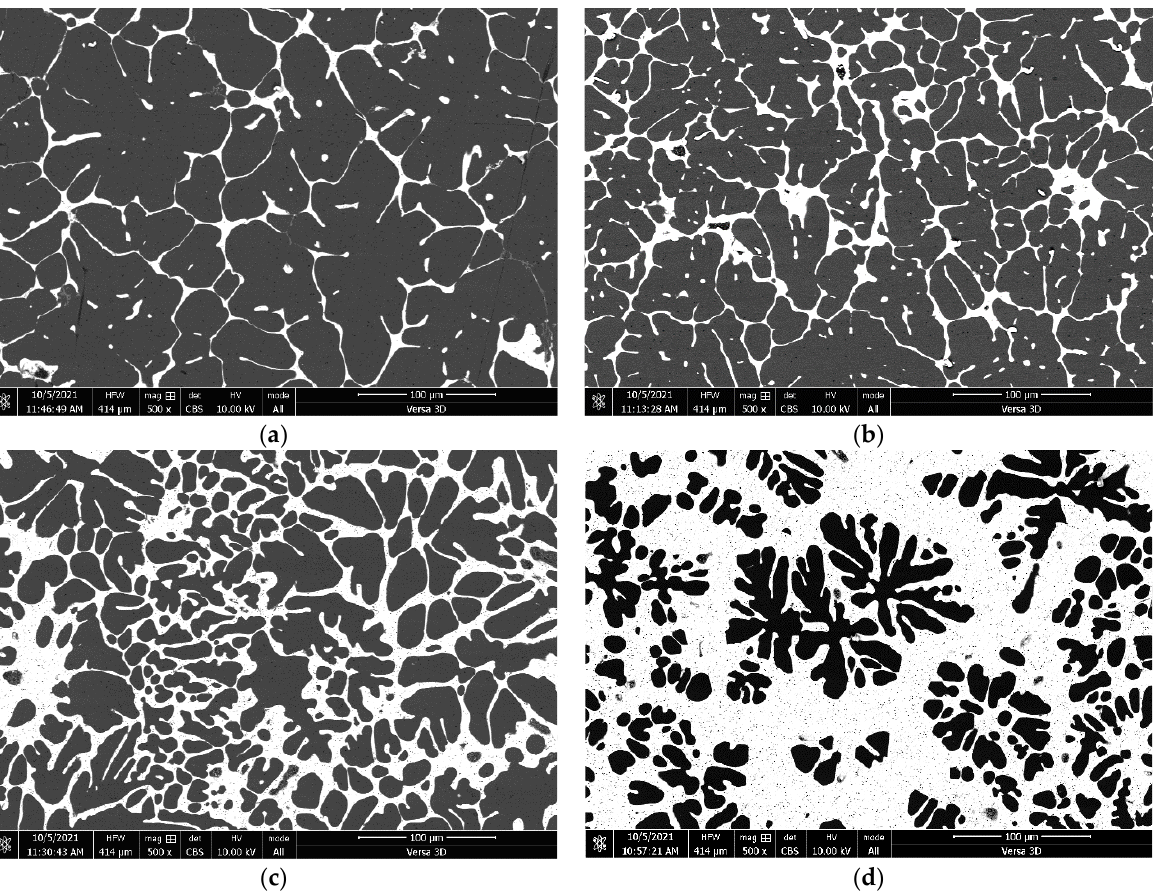
Figure 2. Microstructure of an Al-Sn matrix alloy with tin content from 5 to 50 at.%: ( a ) 5% Sn, ( b ) 10% Sn, ( c ) 25% Sn, ( d ) 50% Sn. Metals 2021 , 11 , x FOR PEER REVIEW